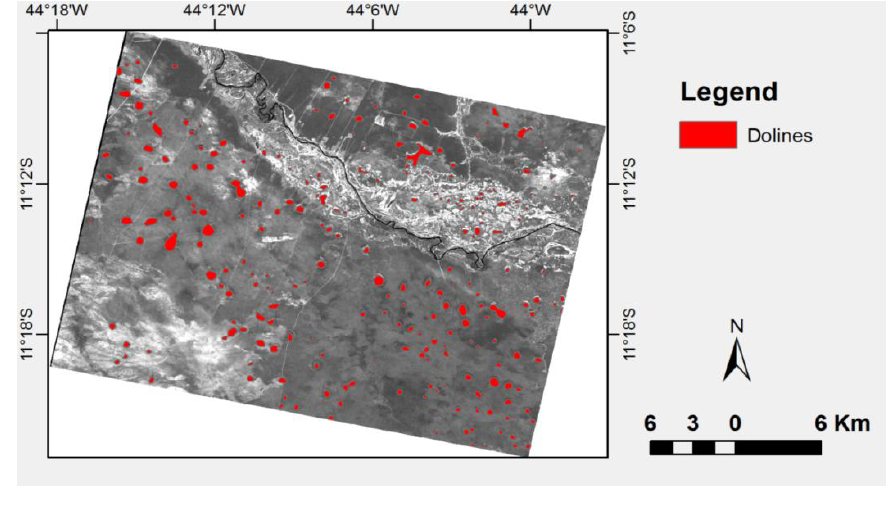
Figure 5. Reference map from the visual interpretation of ALOS/PRISM and Google Earth